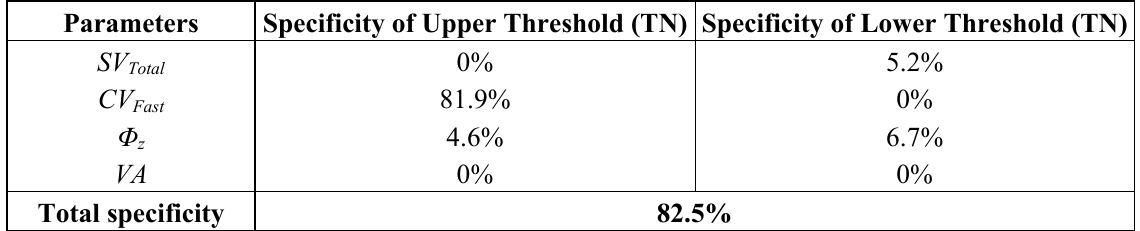
Table 10. The testing results of threshold-based methods for all of the ADLs. Parameters